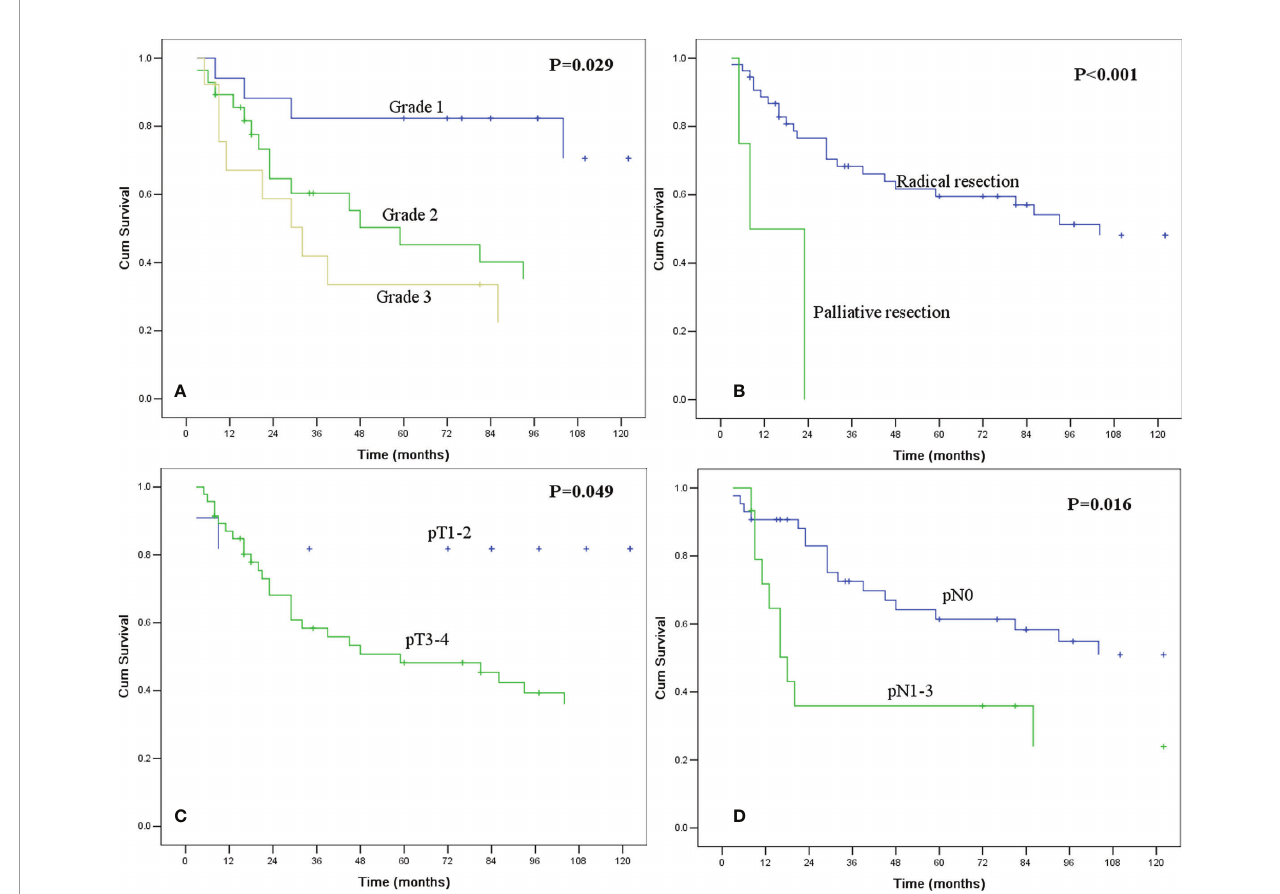
FIGURE 1 | Kaplan-Meier curves for overall survival according to histologic grade (A) , resection margin (B) , pT category (C) , and pN category (D) . All of the survival differences were signi fi cant (P <0.05).